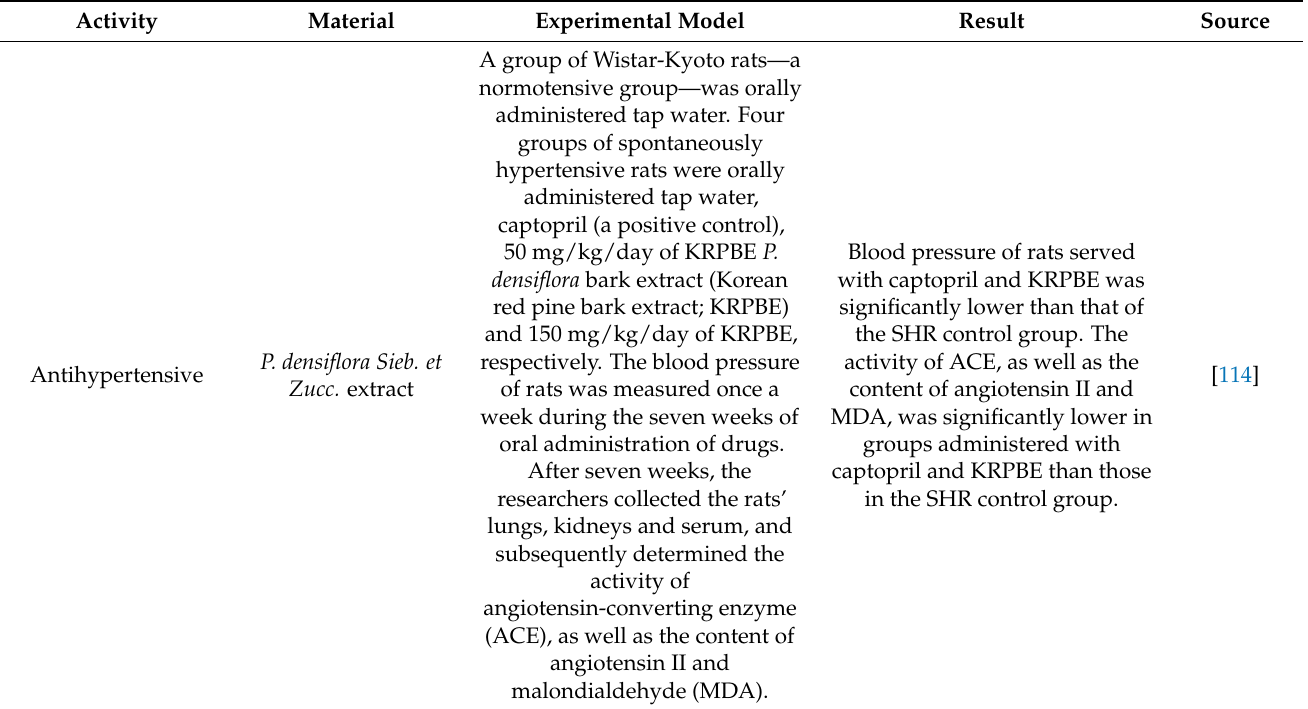
Table 7. Pharmacological properties of Pinus